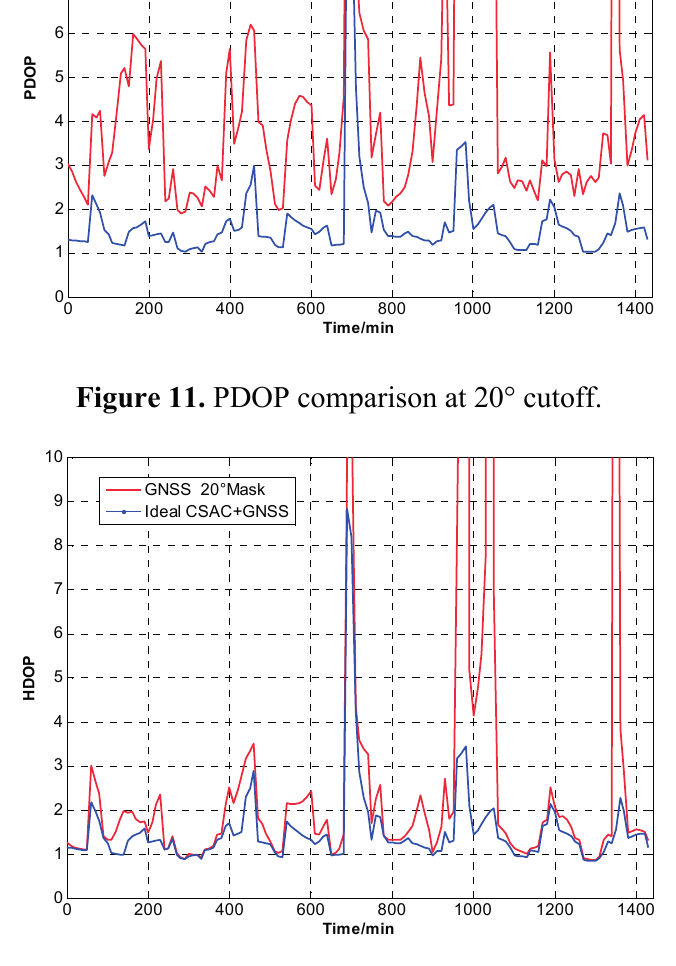
Figure 12. HDOP comparison at 20°